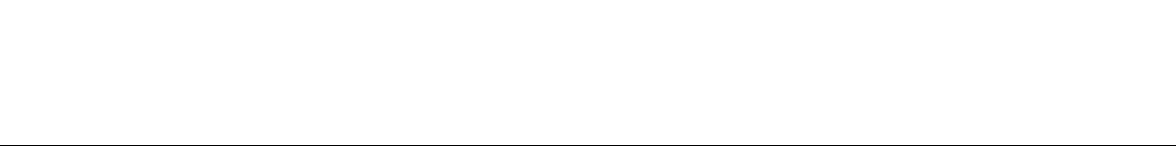
TABLE 1 | Comparison of energy densities of the blend prepared in this study with other dielectric polymers between 70 and 90 ° C.